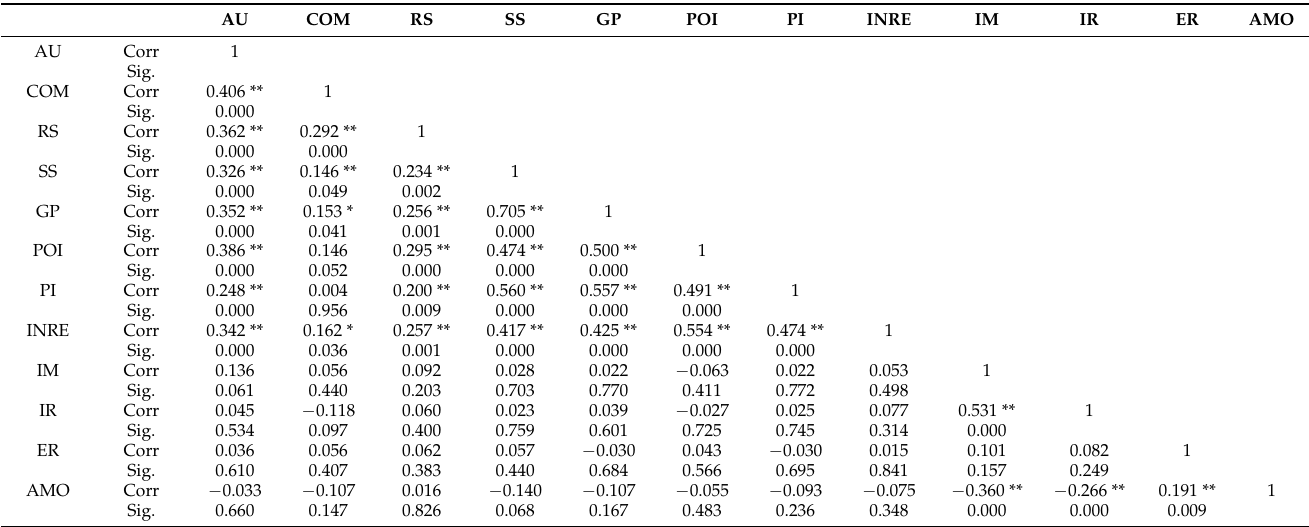
Table 6. Bivariate